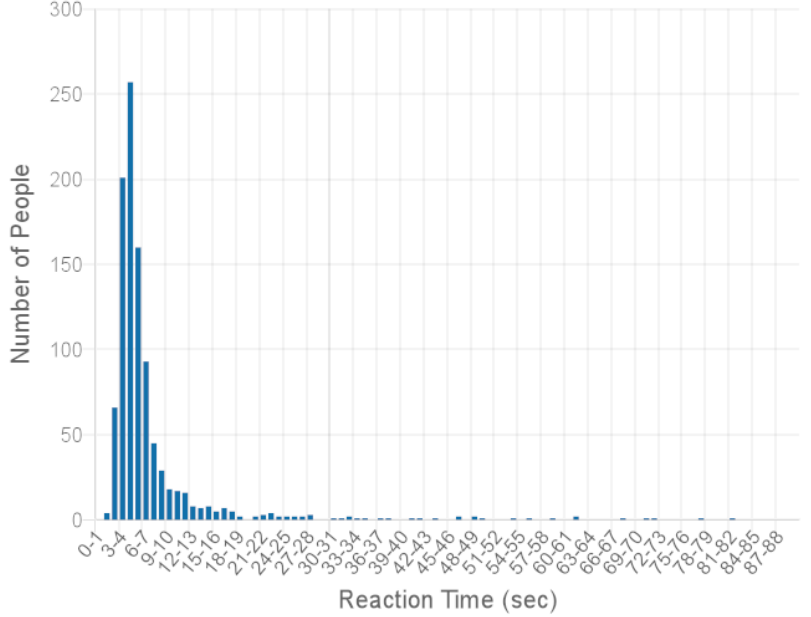
Figure A6. Reaction time distribution for Legacy PC category, question PQ610. Missing values in the histogram: 6.